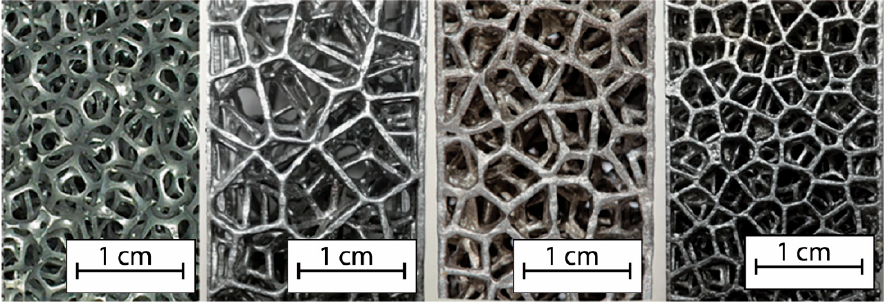
Figure 6. Metal foam objects of this work, from left to right, Duocel ® , 5 PPI designed, 7 PPI designed, and 10 PPI designed.